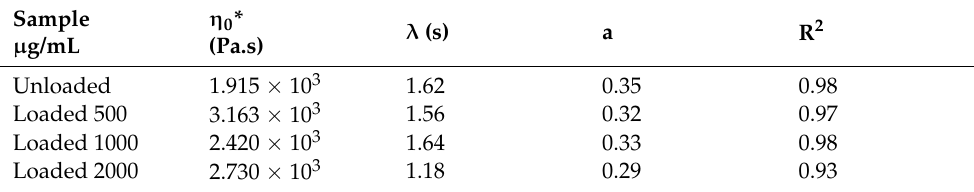
Table 5. Carreau-Yasuda parameters from unloaded and loaded bigels with Quercus resinosa extracts.